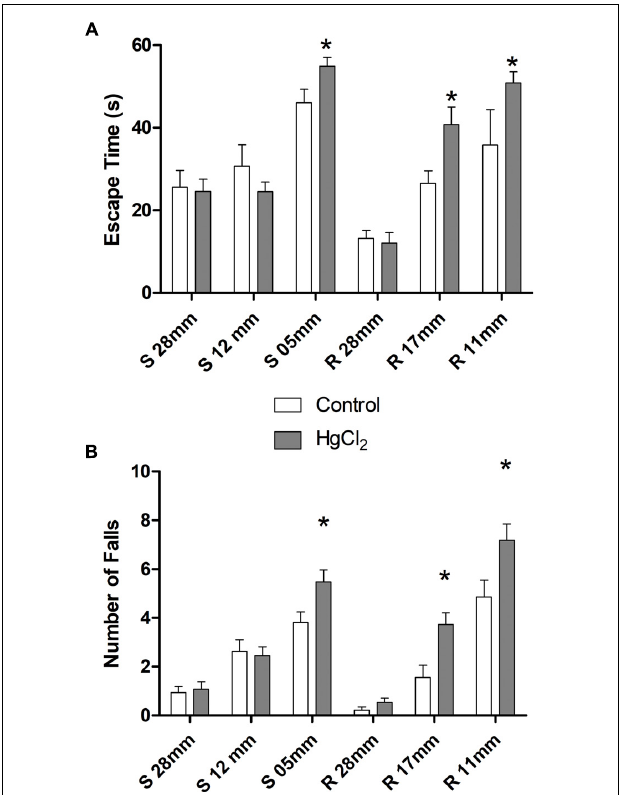
FIGURE 3 | Effects of chronic exposure to HgCl 2 on fine motor coordination and balance of adult Wistar rats. The results are expressed as mean ± standard error of (A) latency (s) and (B) failure numbers. ∗ p < 0.05 compared to the control group (Student’s t -test).